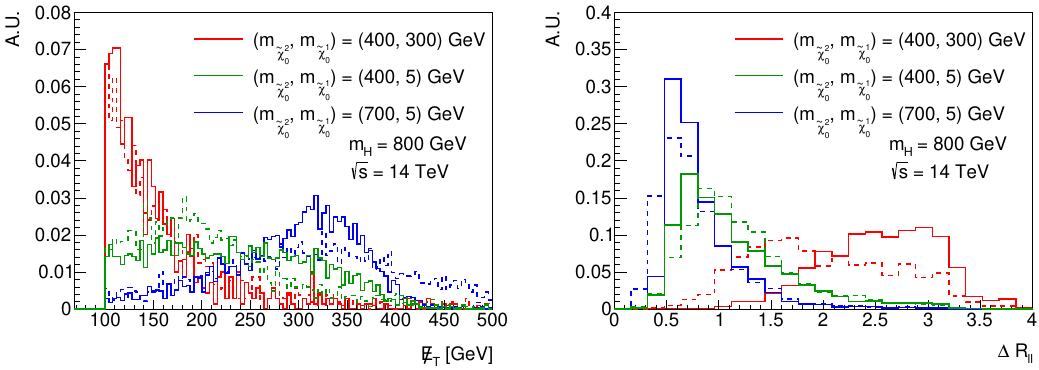
Figure 10. Normalised distributions for missing energy of the events (left) and ∆ R between two leptons (right) with preselections as defined in the text for three different benchmark points. The dashed lines represent production via SM mediated processes and the solid lines represent production via heavy Higgs